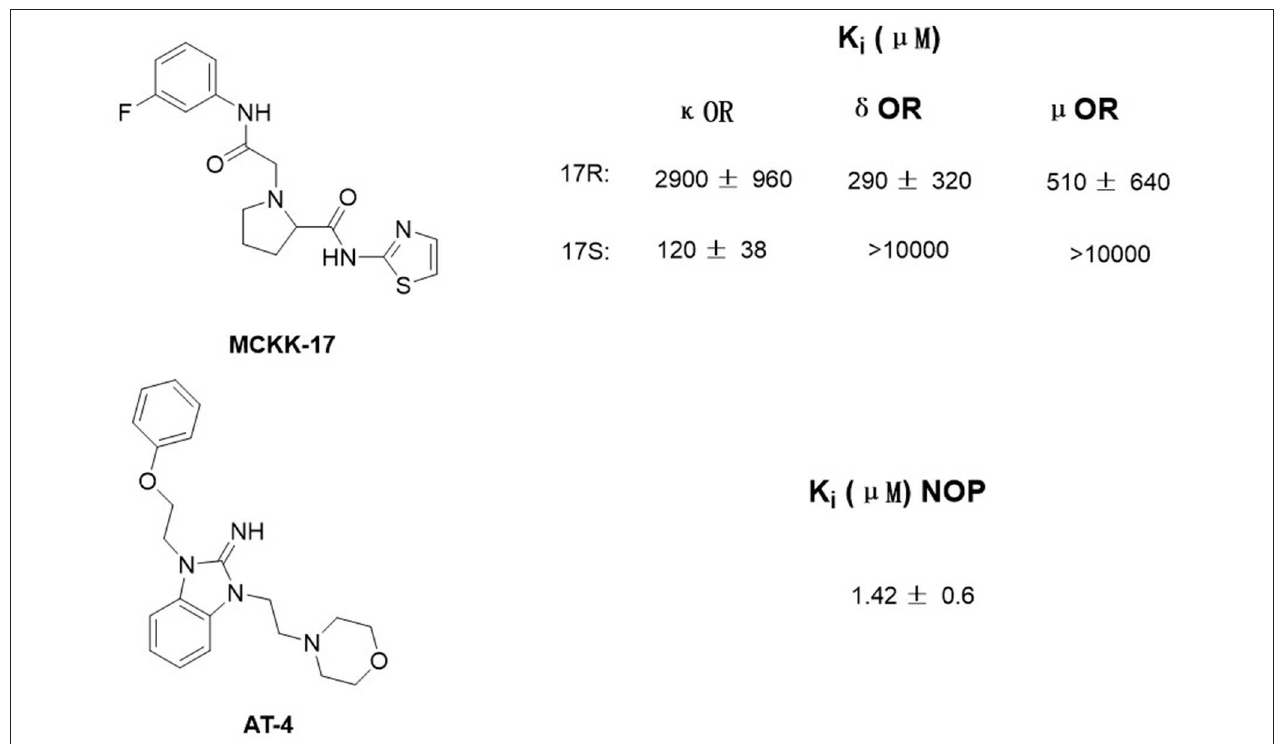
FIGURE 1 | Structure of MCKK-17 and AT-4 found by structure-based virtual screening (SBVS) and their Ki to respective